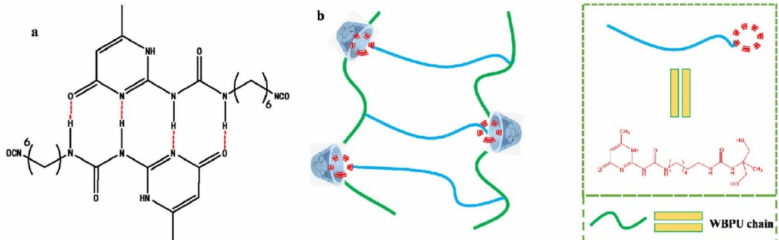
Figure 11. ( a ) Illustration of the self-healing process and the dynamic of the hierarchical H-bond interaction. ( b ) Schematic diagram of the interaction between guest and host. Reproduced from [131] with permission from Elsevier.